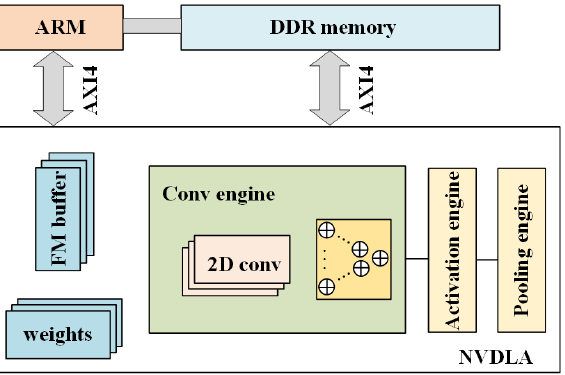
Figure 5. Hardware architecture of the CNN accelerator on the